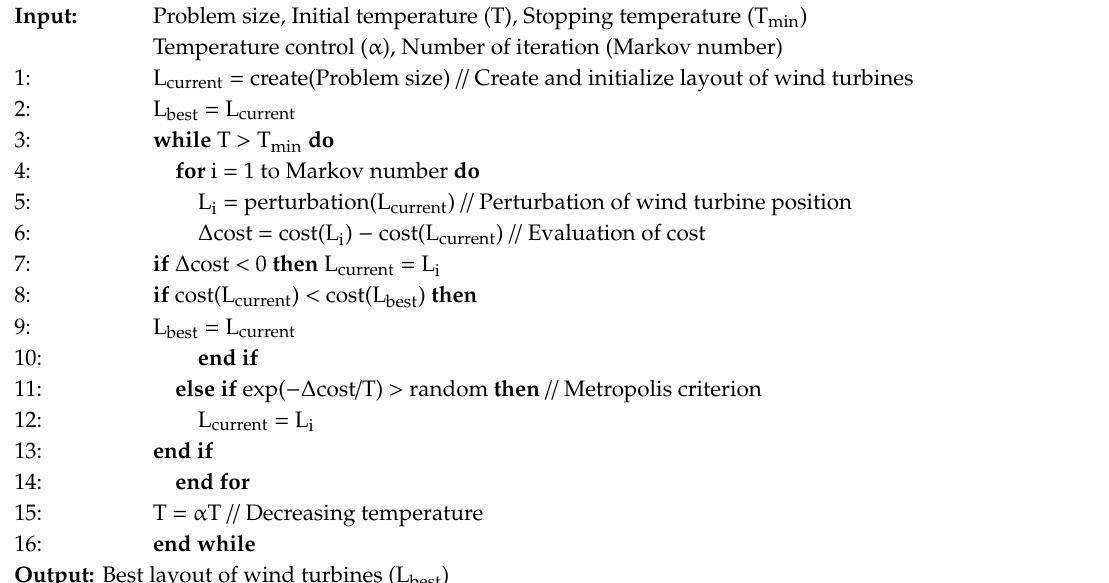
Algorithm 1. Pseudocode of Simulated Annealing for the Wind Farm Layout Optimization.